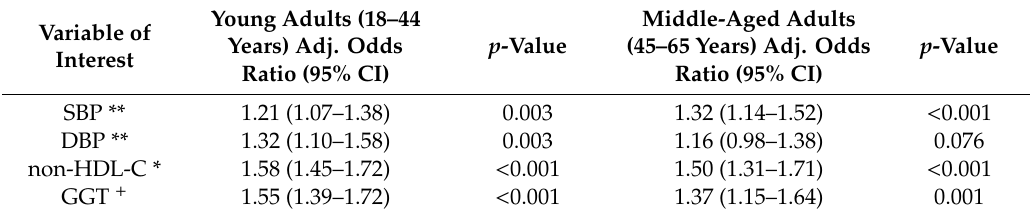
Table 4. Logistic regression of markers of interest among